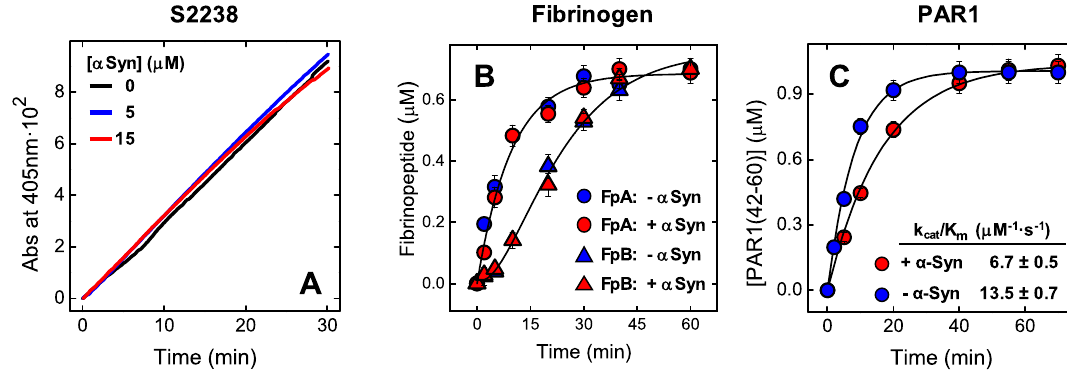
Figure 6. Effect of αSyn on αT-mediated hydrolysis of S2238, Fb and PAR1(38–60). ( A ) αT-catalyzed hydrolysis of the chromogenic substrate S2238 in the presence of increasing αSyn concentrations. The hydrolytic activity was determined at 37 °C in HBS by measuring the release of p -nitroaniline ( p NA) at 405 nm. ( B ) Release of FpA and FpB from desalted fibrinogen (0.35 μM) by αT (300 pM), in the absence or presence of αSyn (15 μM). Measurements were carried out at 37 °C in HBS and quantified by RP-HPLC (see “Methods”). Interpolation of the data points with Eqs. 1 and 2 (Supplemenatry Material), yielded the apparent specificity constants (k cat / K m ) of FpA and FpB release in the absence (k cat,A /K m,A = 7.2 ± 0.9 µM −1 ·s −1 ; k cat,B /K m,B = 5.7 ± 0.6 μM −1 ·s −1 ) and presence (k cat,A /K m,A = 4.7 ± 2.2 μM −1 ·s −1 ; k cat,B /K m,B = 4.6 ± 2.1 µM −1 ·s −1 ) of 15 μM αSyn. ( C ) Cleavage of PAR1(38–60) by αT in the absence and presence of αSyn (15 μM). The cleavage of PAR1(38–60) peptide (1 μM) by αT(150 pM) was carried out at 25 °C in TBS and the time course of PAR1(42–60) fragment release quantified by RP-HPLC. The data points were fitted with Eq. 3 (Supplemenatry Material), to yield the values of k cat /K m in the absence and presence of αSyn. The data points are the average of three independent measurements (n = 3), with errors as ±